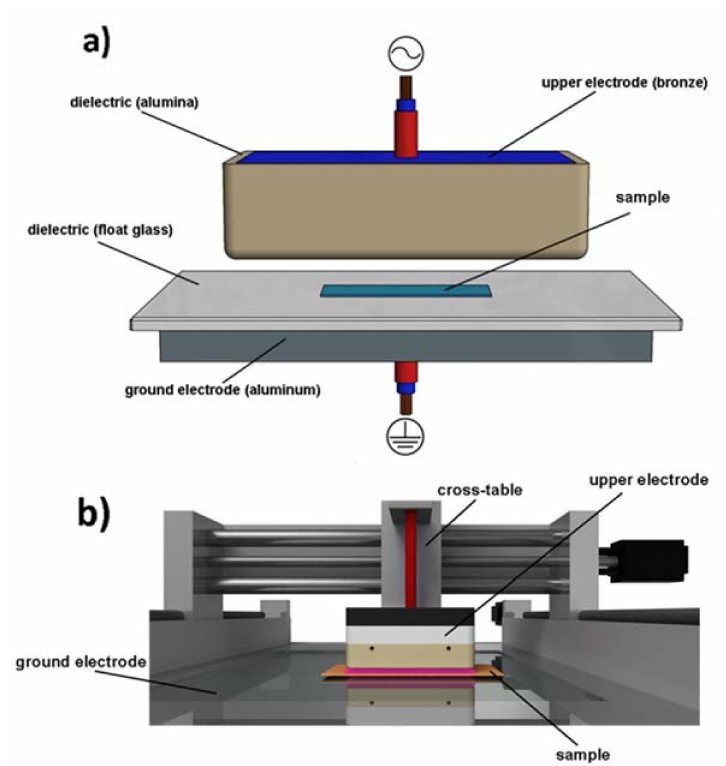
Figure A1. ( a ) Electrode configuration. The sample is placed on a glass-insulated aluminum ground electrode. Above the specimen and a 2 mm treatment gap is the upper electrode ( b ) experimental setup scheme. The upper electrode is mounted on a 3-axis cross table and can be moved over the specimen to ensure an accurate 2 mm treatment gap and complete coverage of the sample with the upper electrode. (Adapted from ten Bosch et al.